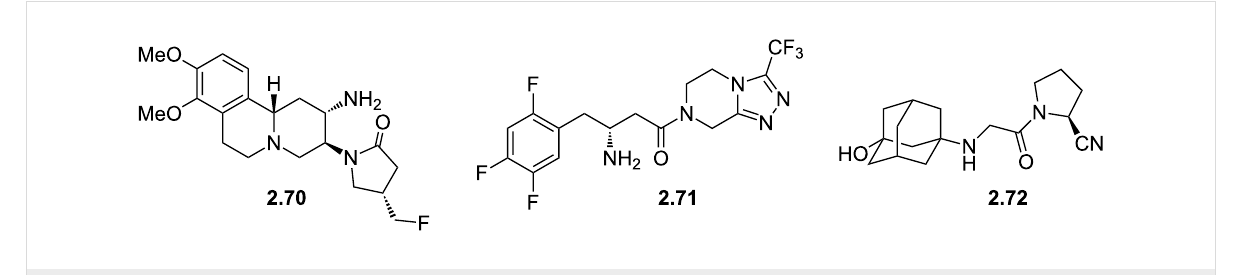
Figure 7: Structures of DPP-4 inhibitors of the gliptin-type.